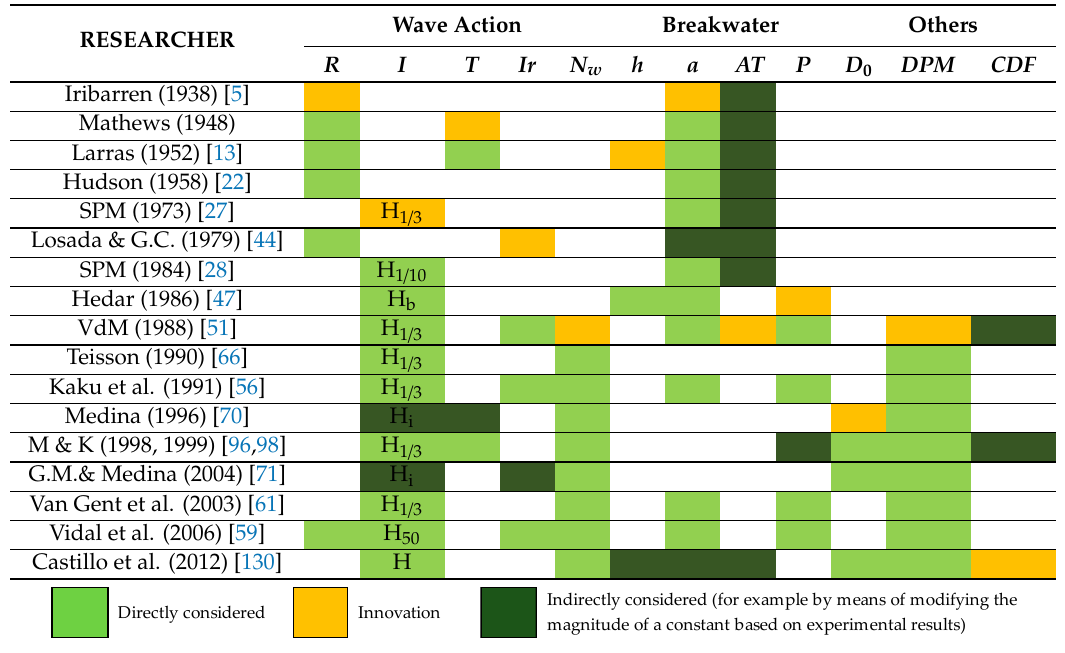
Table 3. Timeline of some of the most relevant models on armor layer's stability, together with the parameters/properties accounted for and the innovations introduced by each of them. See Appendix B for the list of symbols.